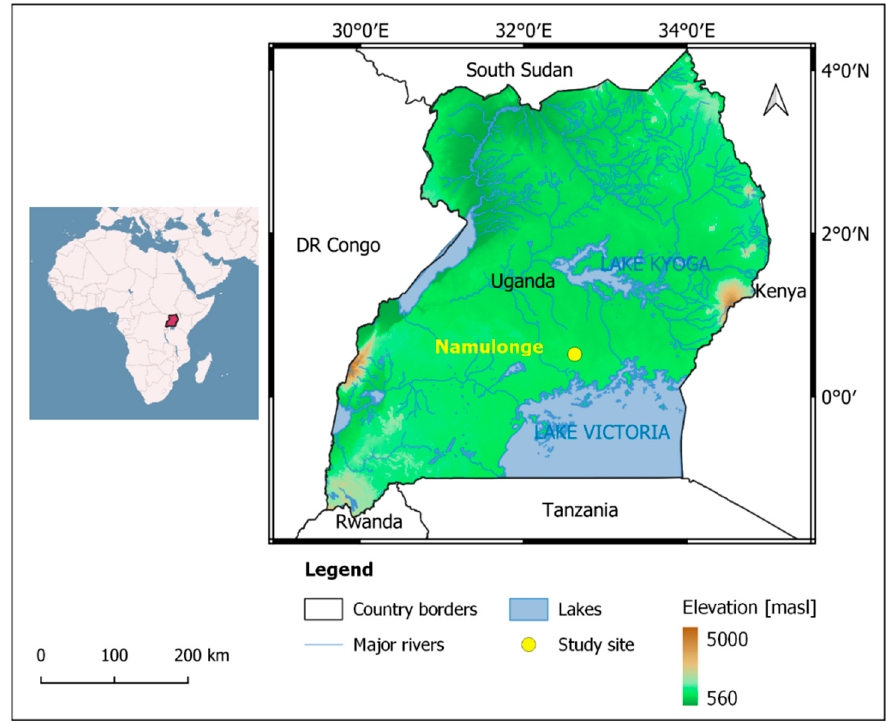
Figure 1. Topographic map of Uganda and the position of the Namulonge study site.